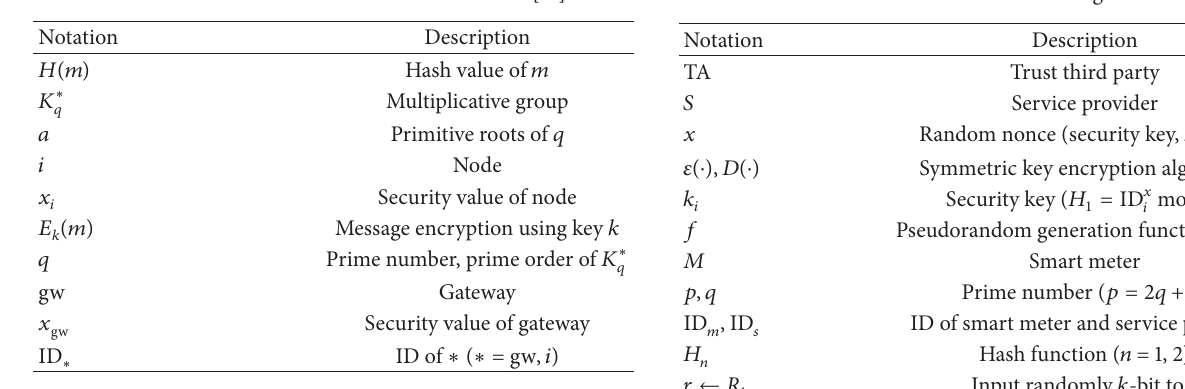
Table 1: Notations used in Kamto et al.’s scheme [10]. Table 2: Notations used in Xia and Wang’s scheme